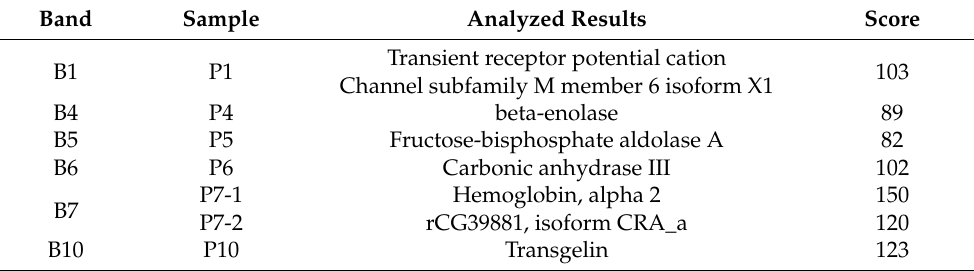
Table 3. Identification of protein components via the NCBI